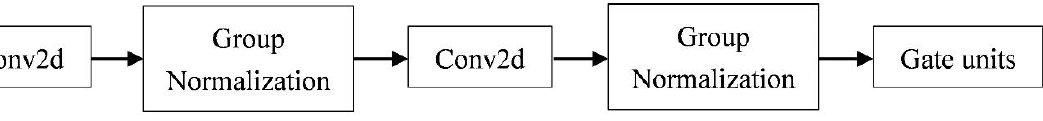
Figure 5. ConvLSTM unit structure.